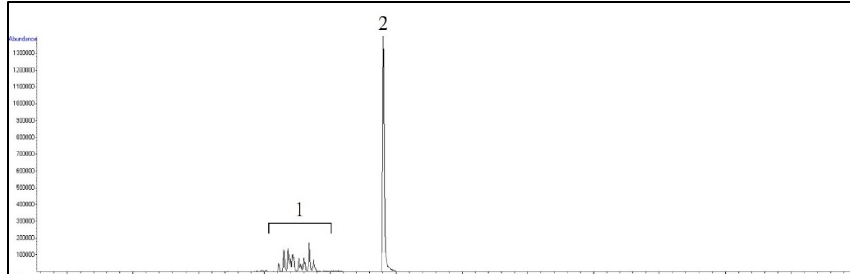
Figure 1. GC/MS total ion chromatogram of analytes. Peaks: 1, NPs; 2, 4-n-NP and 4-n-NP 13 C 6 .